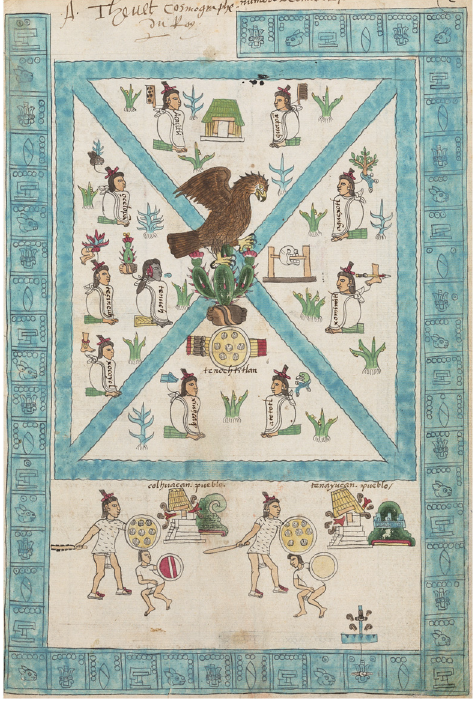
Figure 2. Representation of the emblem of Tenochtitlan from the Codex Mendoza, with the prickly pear as the center of the universe. Photo: © Bodleian Libraries, University of Oxford; Shelfmark: Bodleian Library MS. Arch. Selden. A. 1; Holding Institution: Bodleian Libraries, University of Oxford; Terms of use: CC-BY-NC 4.0.